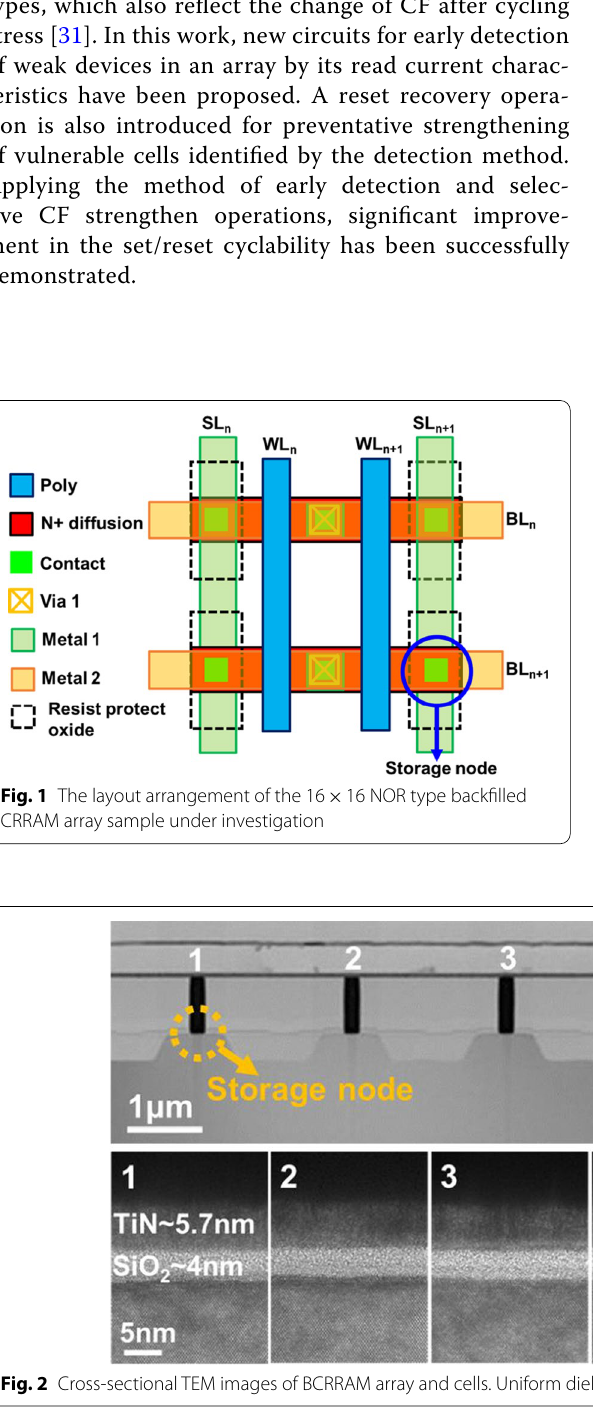
Fig. 2 Cross‑sectional TEM images of BCRRAM array and cells. Uniform dielectric thickness can be obtained in BCRRAM